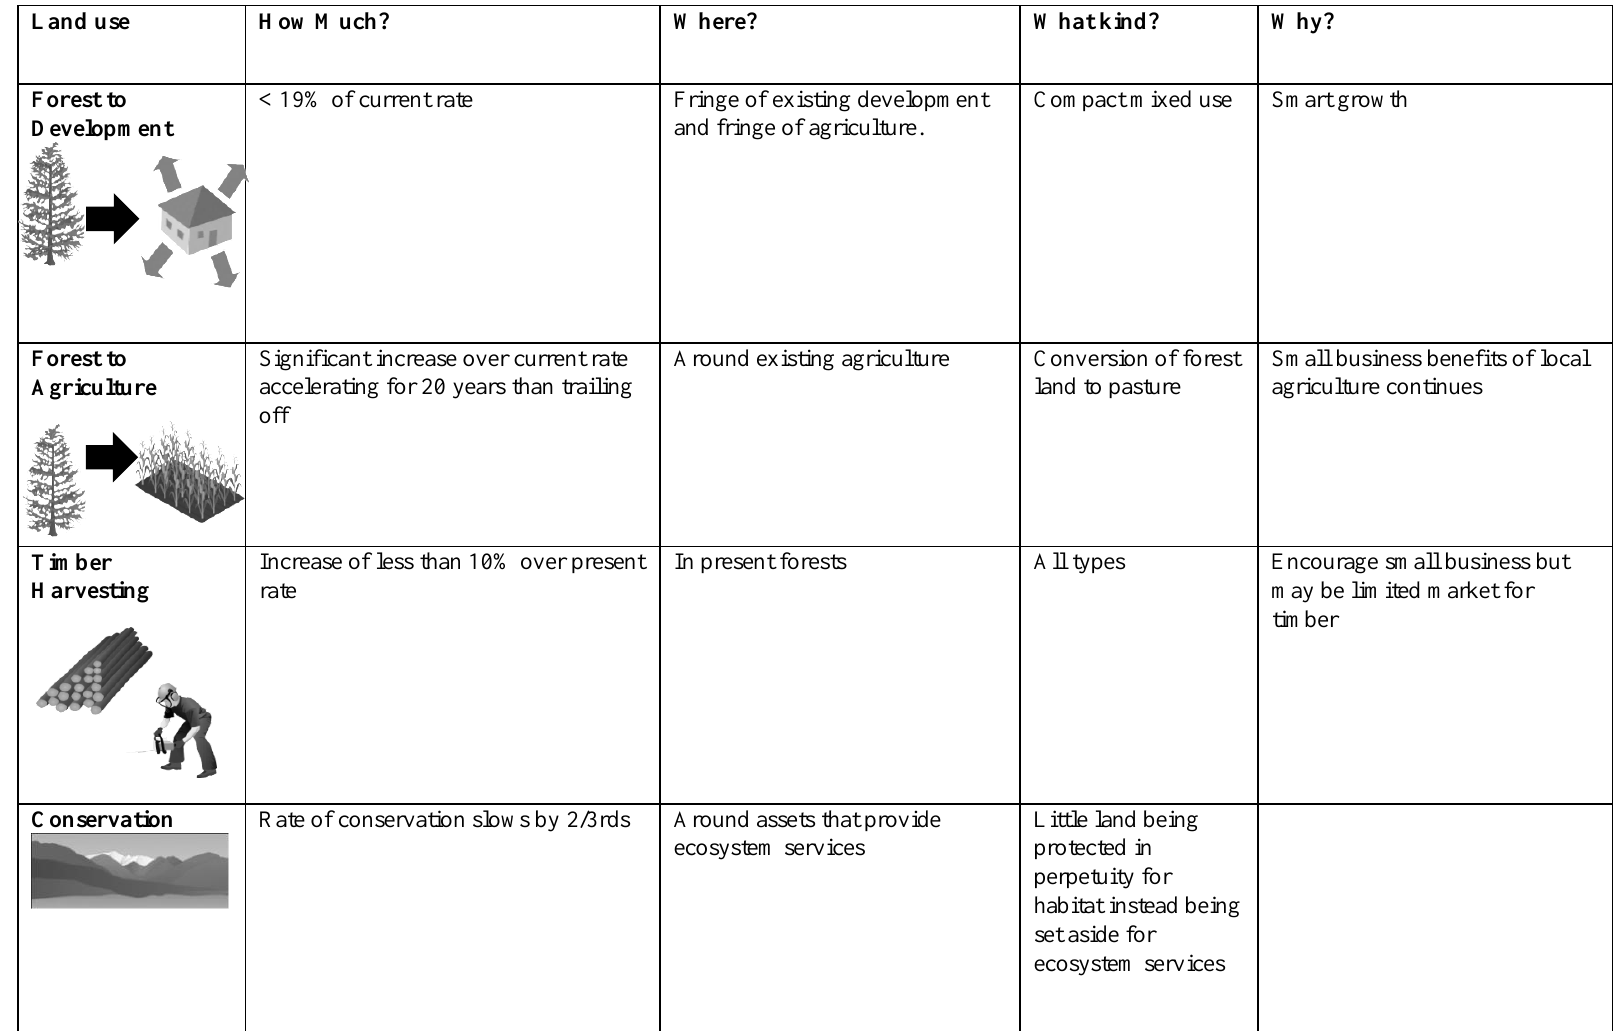
Table A2.20. Scenario 4: A Wrinkle in Time Land use Forest